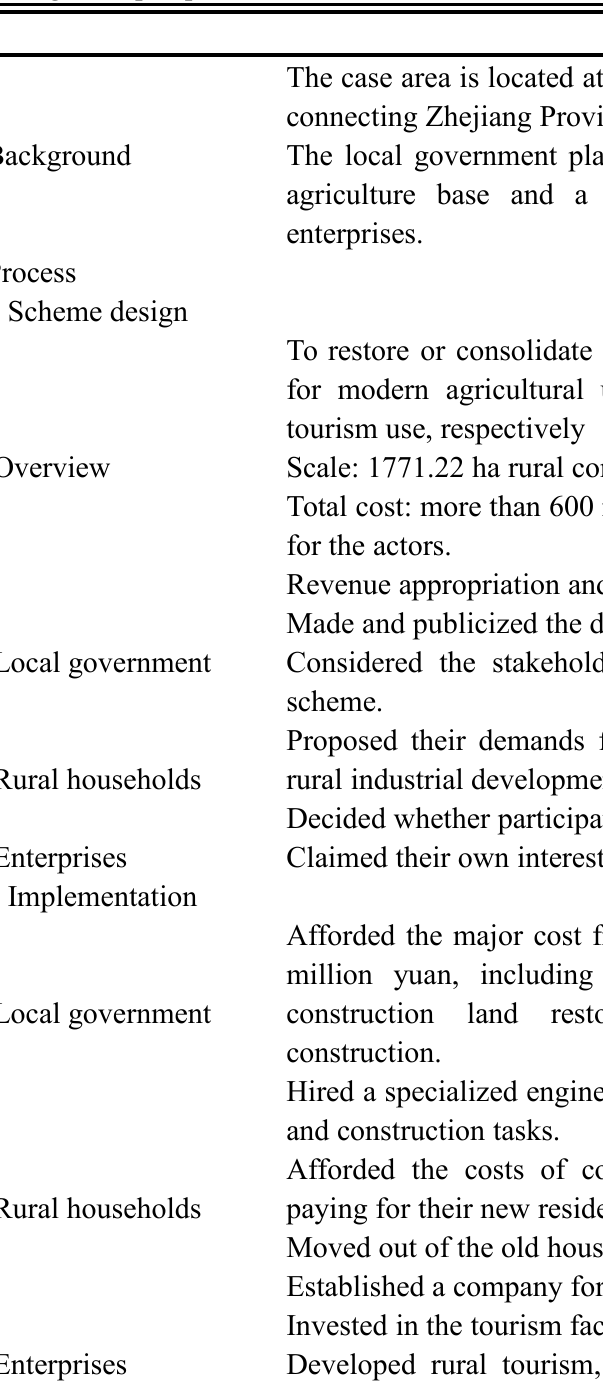
Table A3.6: Archetype 6 Enterprise participation in large-scale rural renewal with a long-term